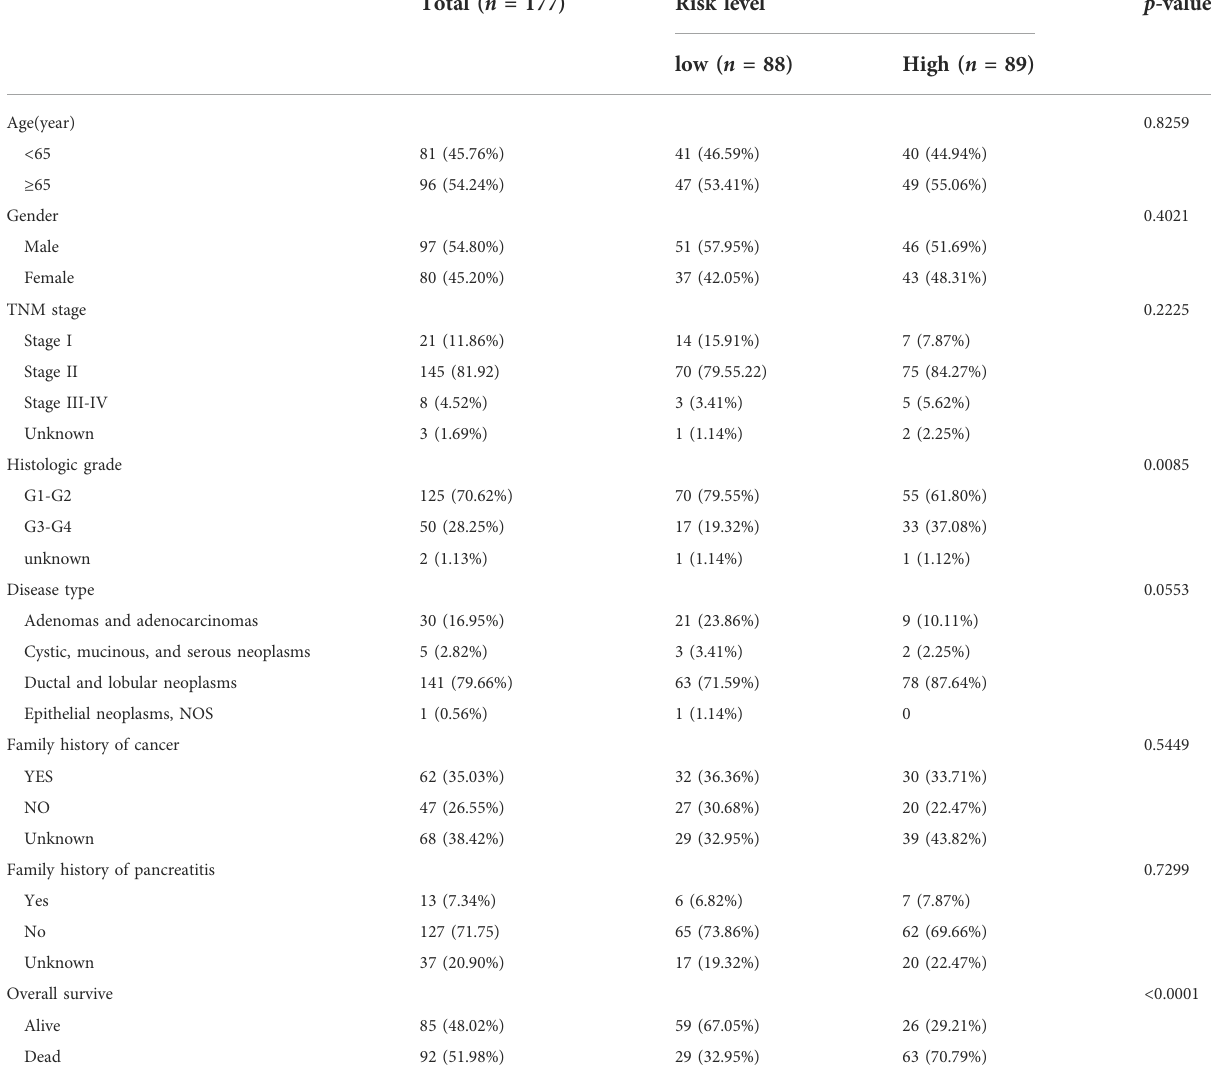
TABLE 1 Clinical characteristics between risk score related